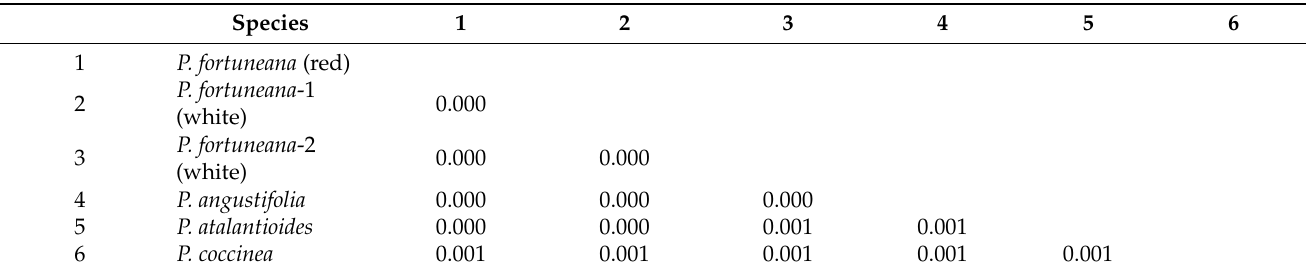
Table 5. The genetic distance among six Pyracantha chloroplast genomes.